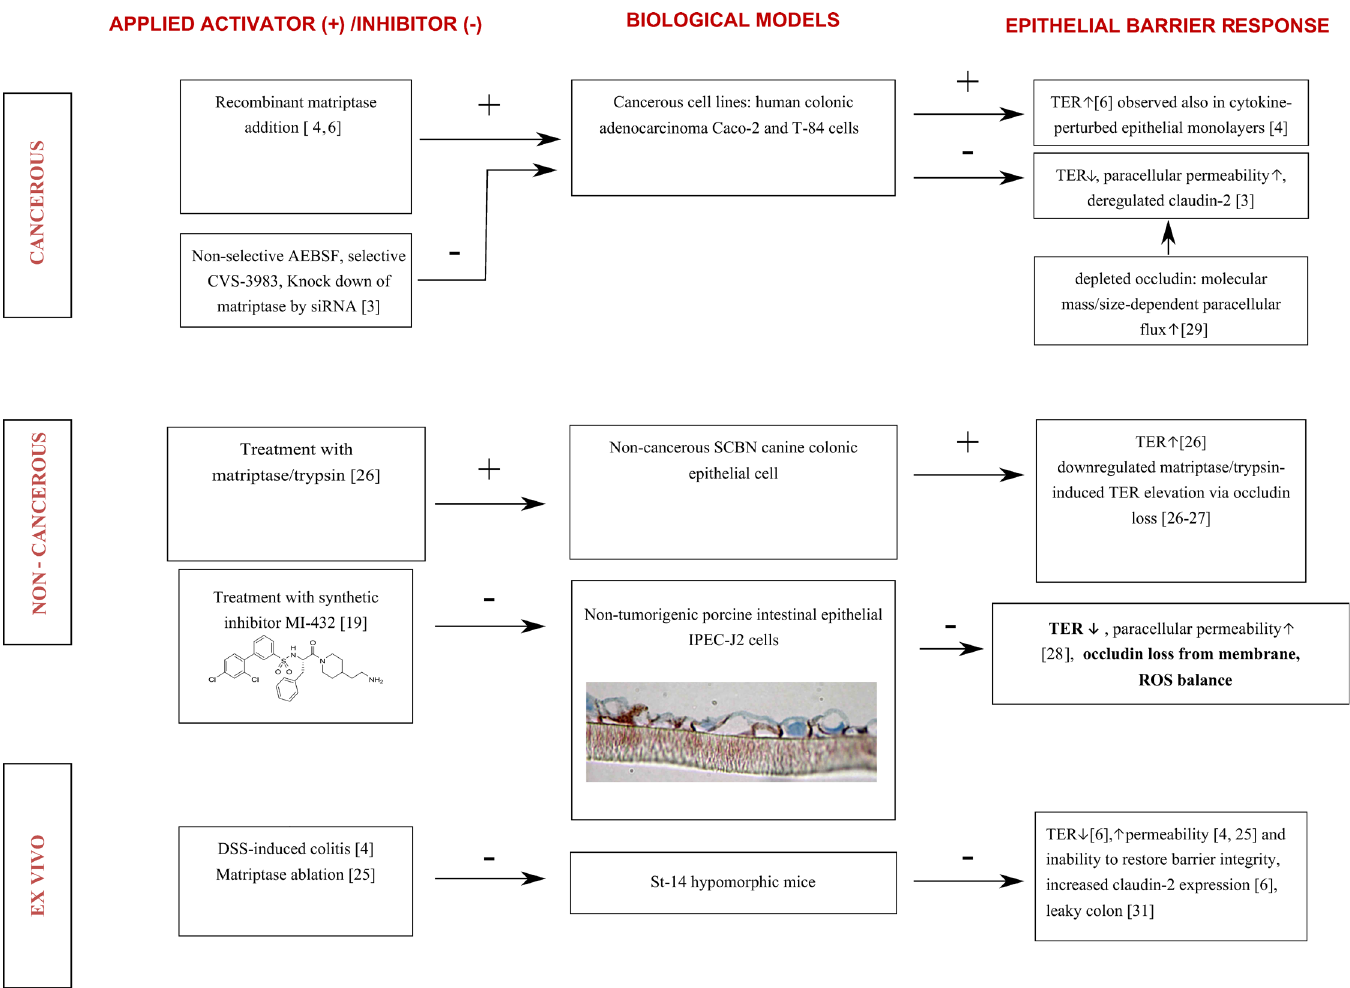
Fig 6. Summary of in vitro and ex vivo findings [31] after externally induced changes in matriptase-activities in the maintenance of intestinal epithelial integrity. TER stands for transepithelial electrical resistance, ST-14 means suppression of tumorigenicity-14. – indicates inhibition and + is for activation of matriptase-involved proteolytic pathways. Recent findings confirm that physiological barrier function of intestinal epithelium including transepithelial electrical resistance and paracellular efflux regulated by TJ protein assembly requires matriptase